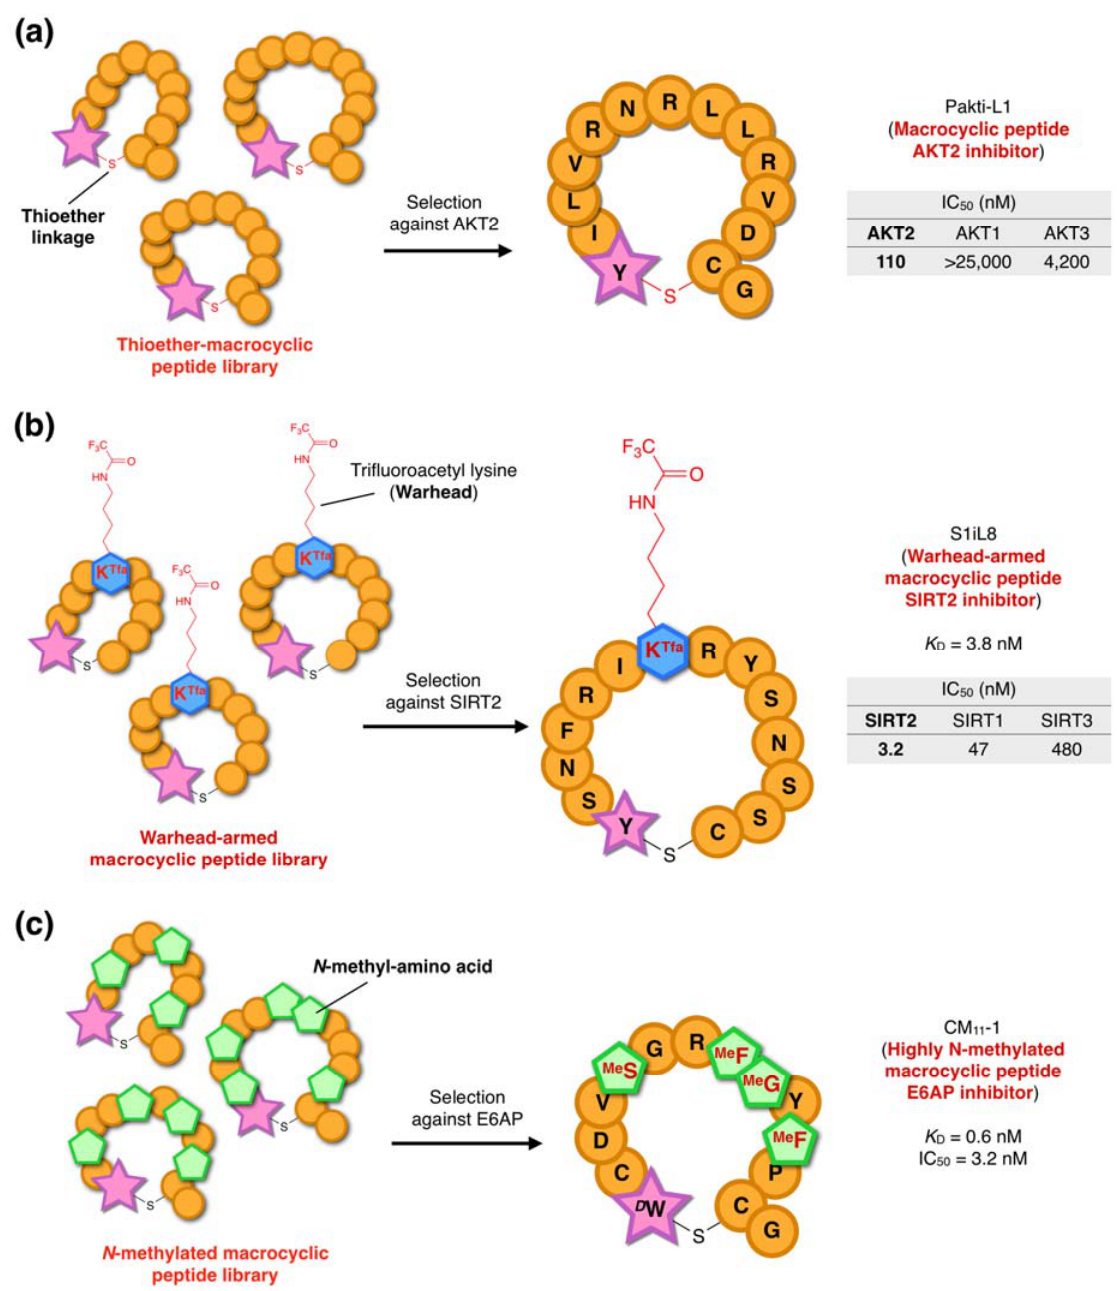
Figure 8. Selection of inhibitors from three distinct non-standard peptide libraries using the RaPID system. ( a ) Anti-AKT2 cyclic peptides. Thioether-macrocyclic peptide libraries were applied to the development of AKT2-selective inhibitors [60]. Pakti-L1 peptide exhibited AKT2-selective inhibitory activity with an IC of 110 nM. ( b ) Anti-SIRT2 50 peptides [64]. Thioether macrocyclic peptides armed with trifluoroacetyl Lys (K Tfa ),